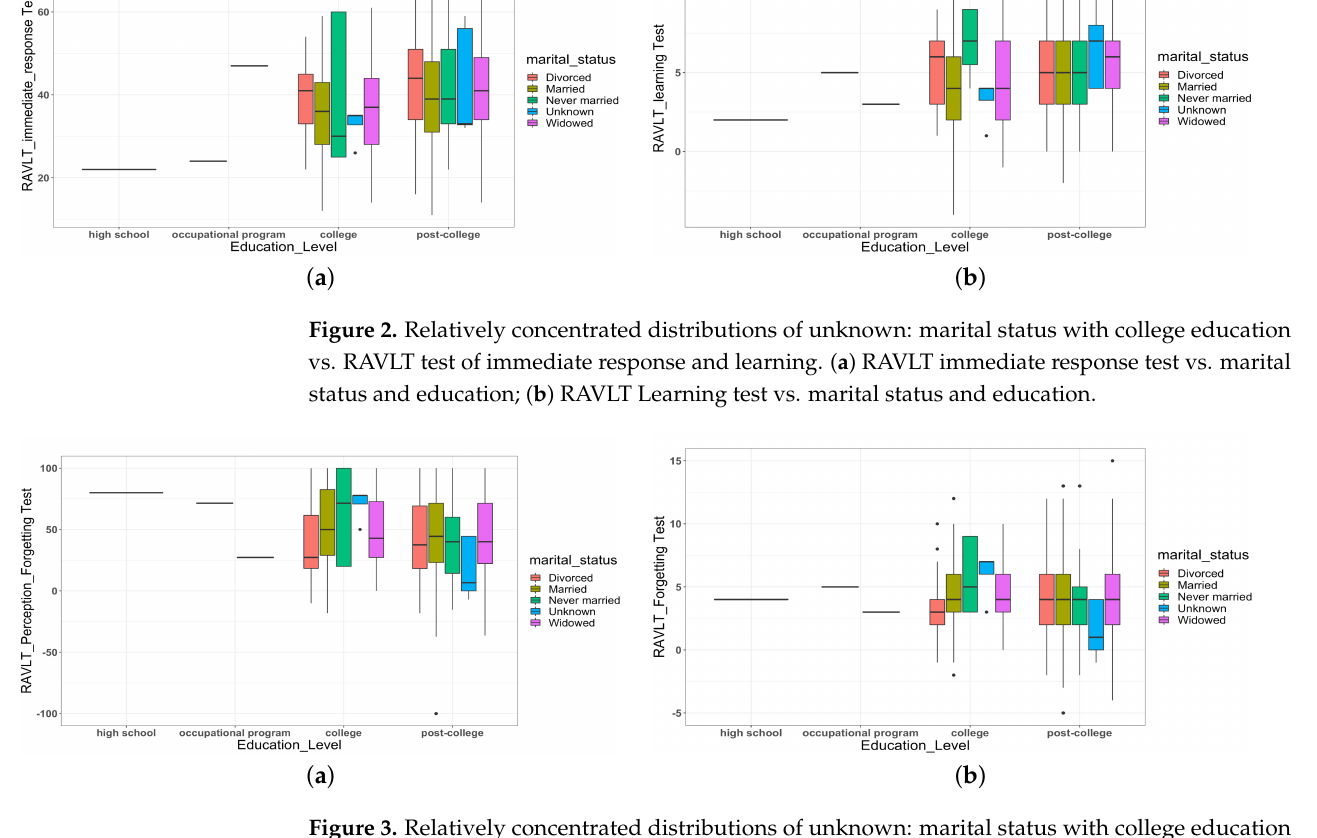
Figure 3. Relatively concentrated distributions of unknown: marital status with college education vs. RAVLT test of forgetting and perception of forgetting. ( a ) RAVLT perception of forgetting test vs. marital status and education; ( b ) RAVLT forgetting test vs. marital status and